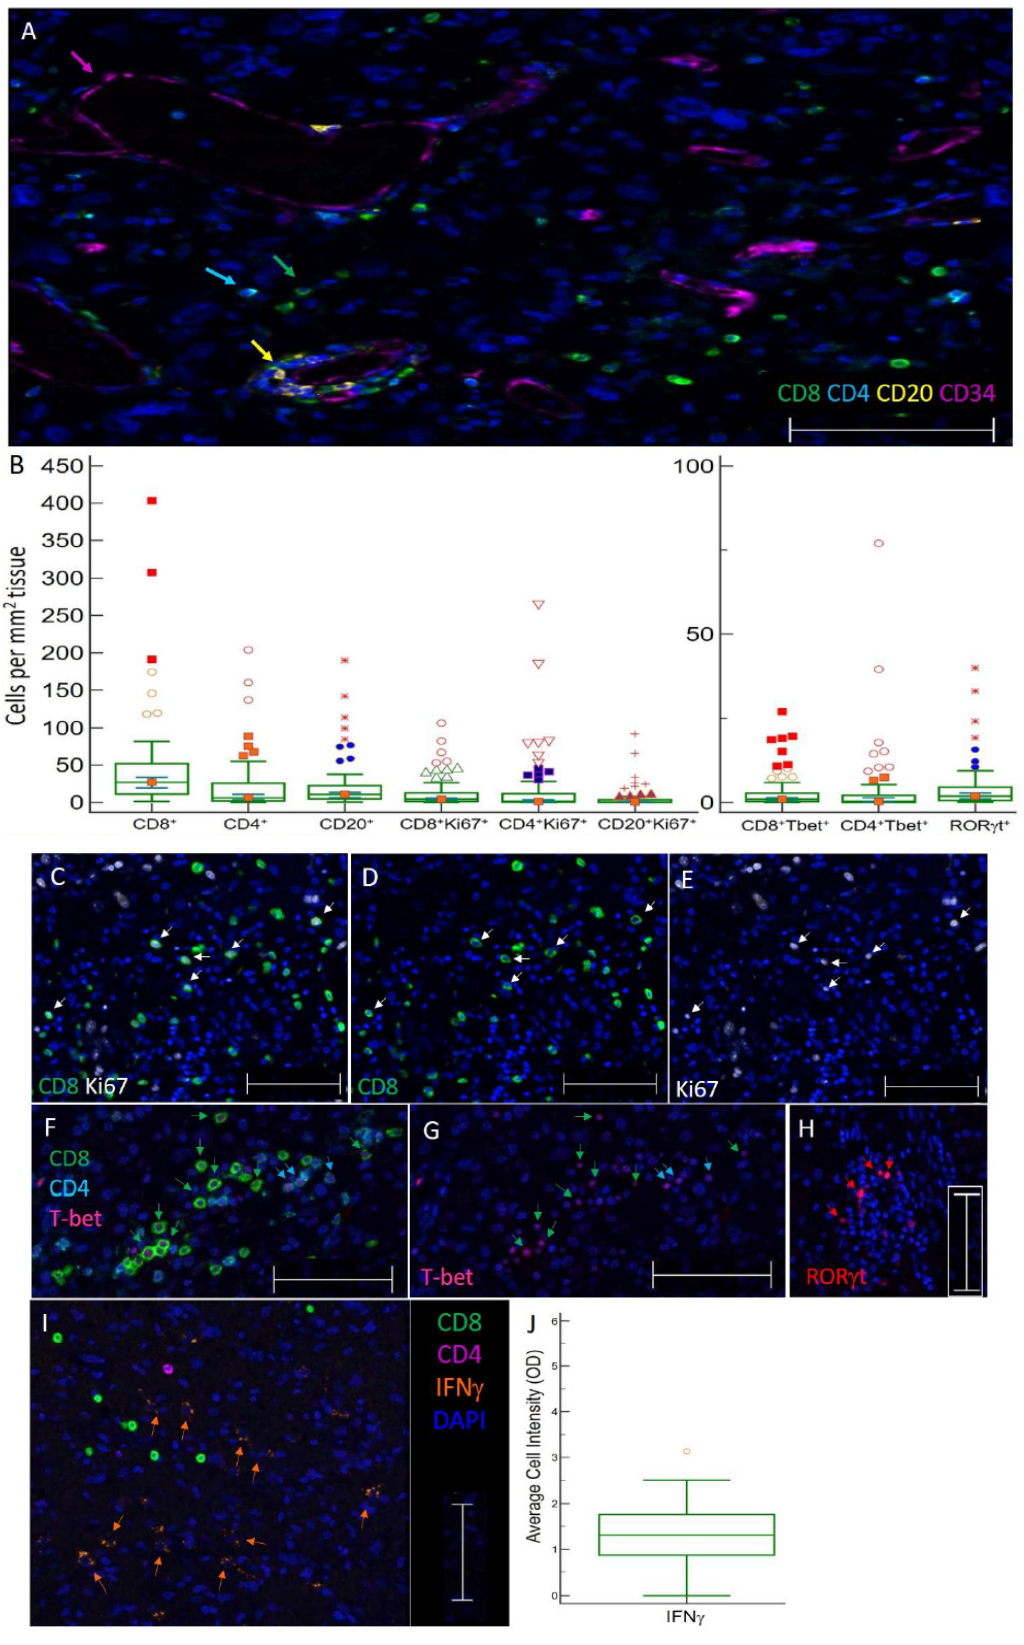
Figure 1. Images of TIL in GBM and immune cell densities. ( A ) Representative 5 color mIFH image of T (CD4 + and CD8 + ) and B cells (CD20 + ) localized near CD34 + endothelial cells in GBM. Colored arrows denote one example of each cell type in image. ( B ) Box plots of the densities of immune cell subsets per mm 2 tissue within GBM. The central box represents values from the lower to upper quartile, 25th to 75th percentile. Middle bar identifies median, and whiskers show mini- mum and maximum, outliers are displayed as separate points. ( C – E ) Images of proliferating CD8 + T cells in GBM. Image C is a 3 color mIFH image showing CD8 + T cells and proliferating Ki67 + cells, Image D depicts CD8 + cells, and image E is of Ki67 + cells, white arrows in each image point to proliferating CD8 + Ki67 + cells. ( F , G ) Image of T-bet + T cells in GBM. Image F is a 4 color mIFH image depicting CD8 + or CD4 + T cells and T-bet nuclear staining, image G shows T-bet expression alone, green arrows denote CD8 + T-bet + cells and cyan arrows denote CD4 + T-bet + cells. ( H ) Image of ROR γ t + cells in GBM, nuclear staining of ROR γ t + is shown in red, and is denoted by red arrows. ( I ) Representative Image of IFN γ t + cells in GBM. Image I is a 4 color mIFH image depicting CD4 + or CD8 + T cells and IFN γ expression in GBM. For all images colors are indicated, scale bars are 100 μ m and DAPI nuclear staining is shown in Blue. ( J ) Box plot of the average cell intensities of IFN γ in GBM.